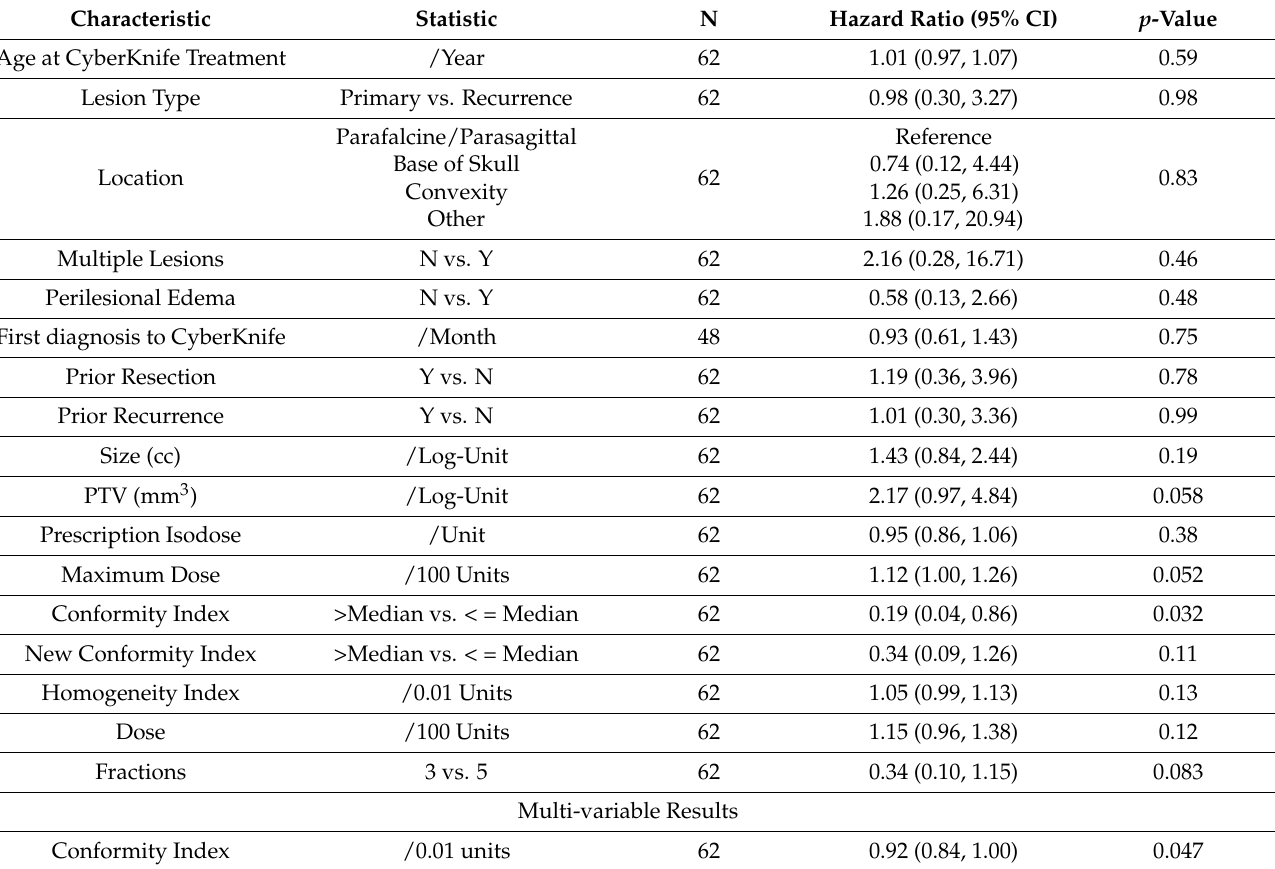
Figure 1. Progression-free survival of patients treated with hSRT. Table 3. Prognostic factors of radiographic progression-free survival using a Cox proportional hazards